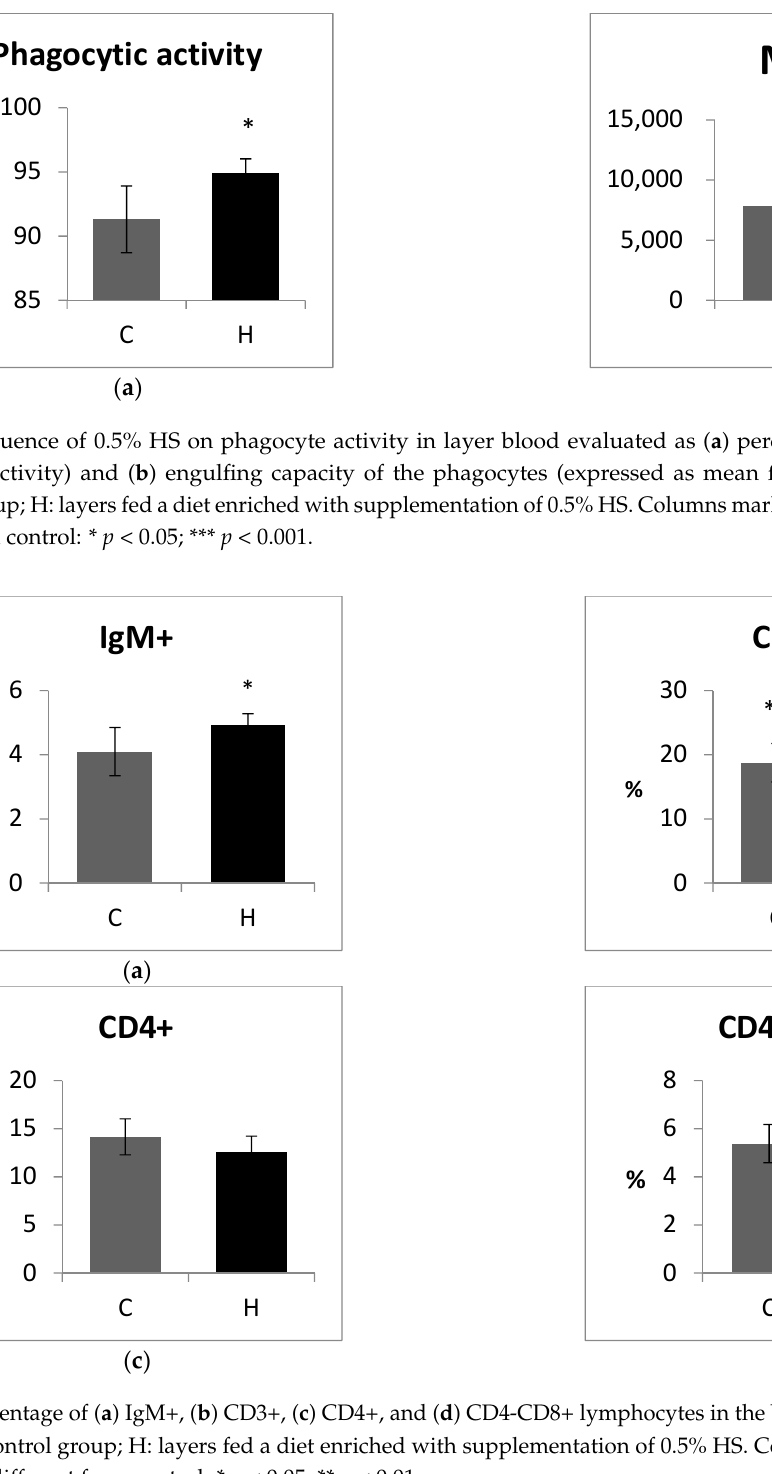
Figure 3. Percentage of ( a ) IgM+, ( b ) CD3+, ( c ) CD4+, and ( d ) CD4-CD8+ lymphocytes in the blood of laying hens receiving 0.5% HS. C: control group; H: layers fed a diet enriched with supplementation of 0.5% HS. Columns marked with stars are significantly different from control: * p < 0.05; ** p < 0.01.